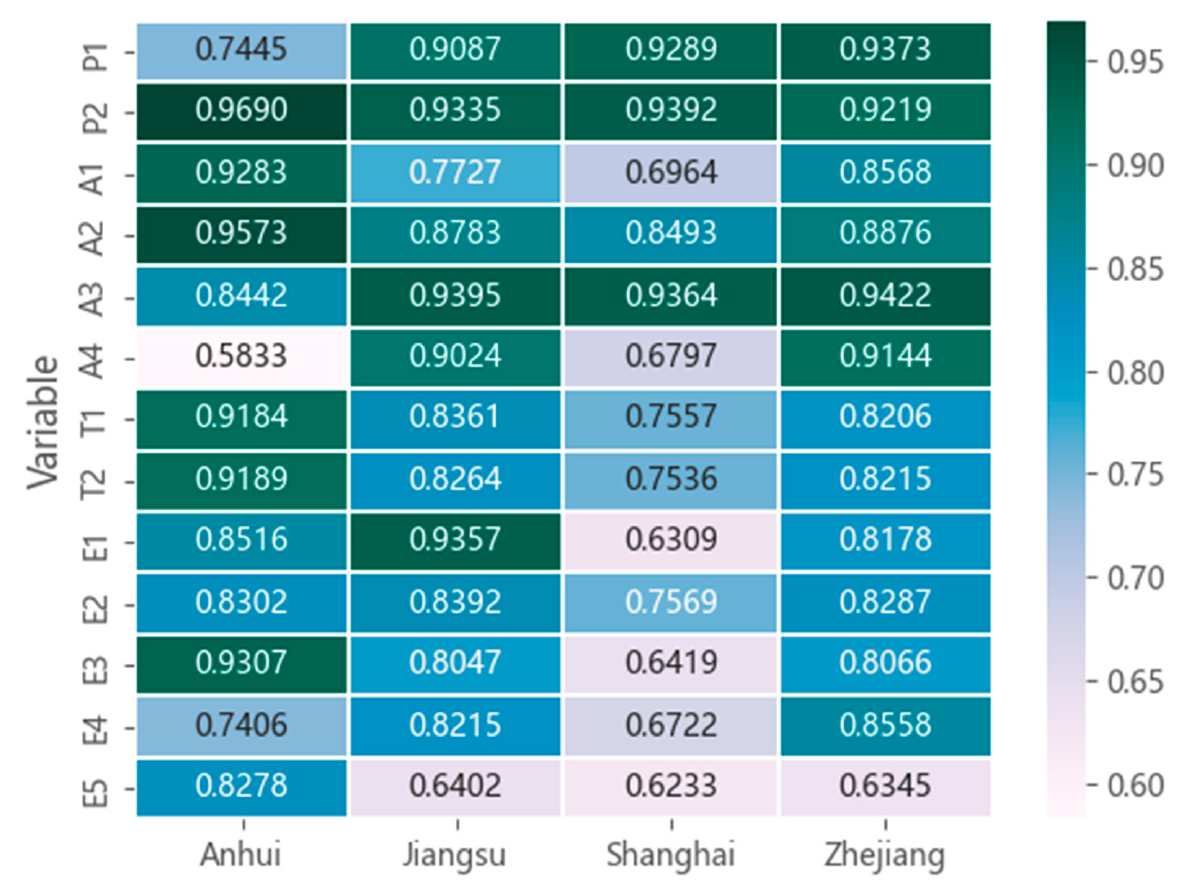
Figure 4. Grey correlation coefficient heatmap.